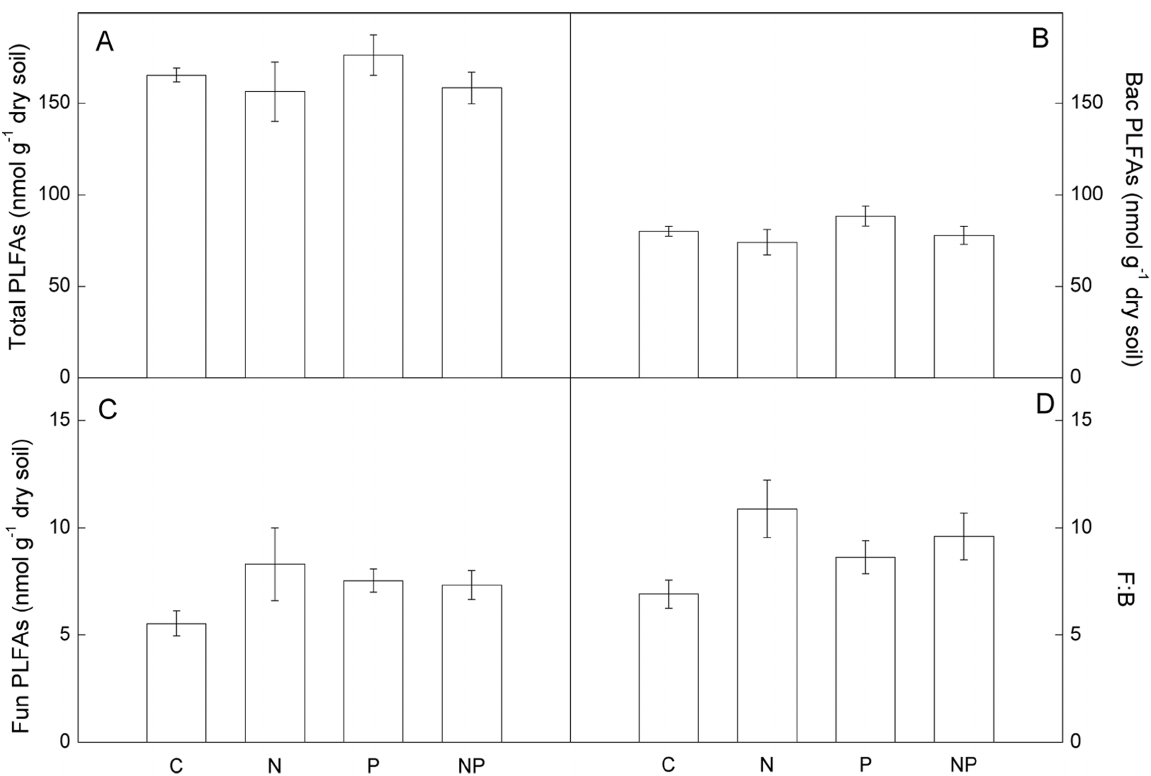
Figure 3. Comparisons of soil microbial PLFAs between treatments. Data from June 2011. C: control, N: nitrogen addition, P: phosphorus addition, NP: nitrogen and phosphorus addition. Bac PLFAs: Bacterial PLFAs; Fun PLFAs: Fungal PLFAs; F:B: the ratio of fungal to bacterial PLFAs. Significant differences (p , 0.05) among treatments are indicated by different letters. Error bars show SE (n=5).